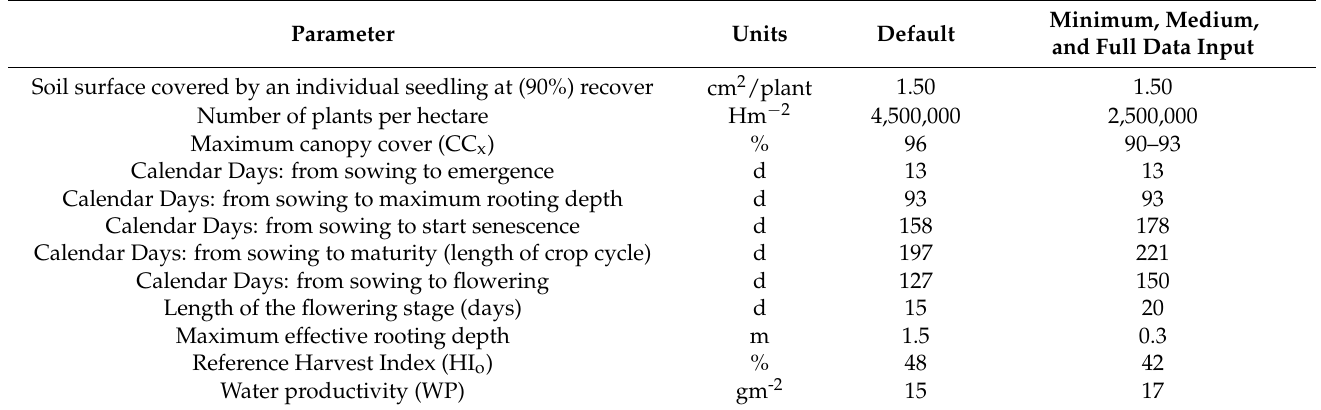
Table 1. User-specific parameters used in